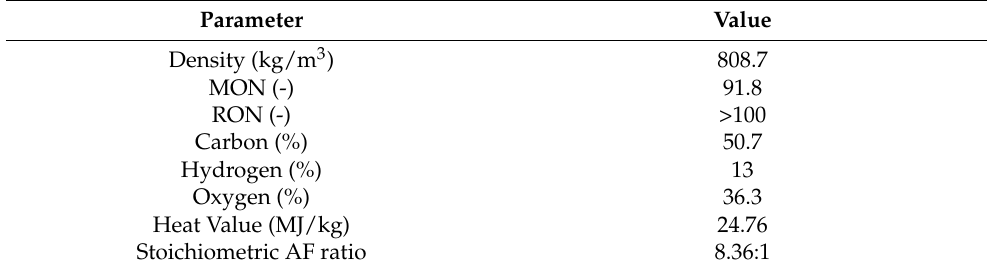
Table 5. Main fuel properties the Brazilian ethanol